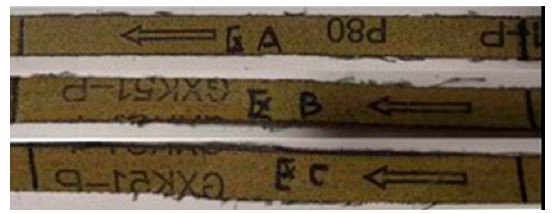
Figure 8. Actual interval labeling.